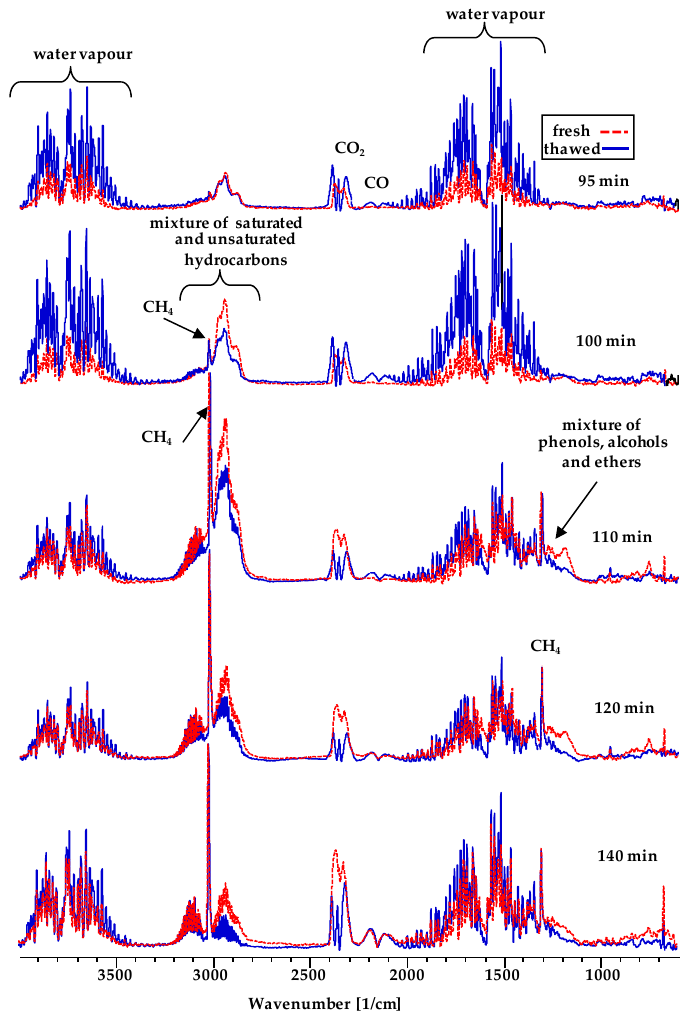
Figure 2. The Fourier transform-infrared spectroscopy (FT-IR) spectra of volatile products of destruction of fresh and thawed coals.